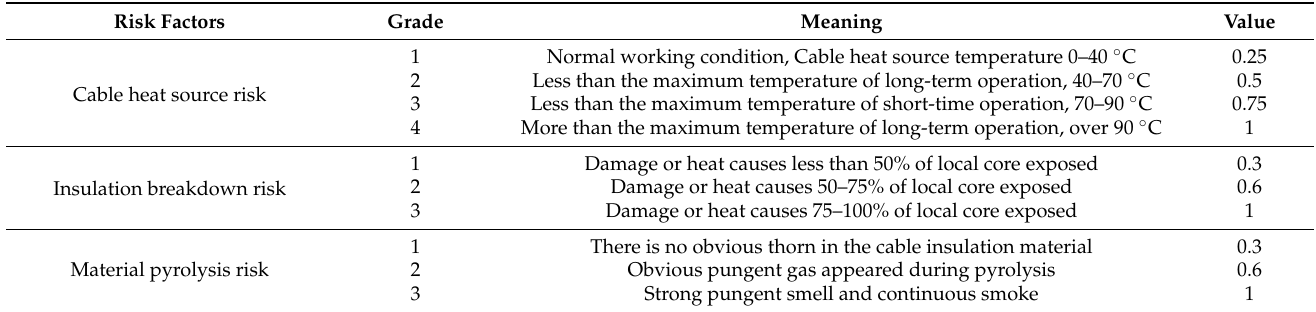
Table 5. Classification of risk factors with